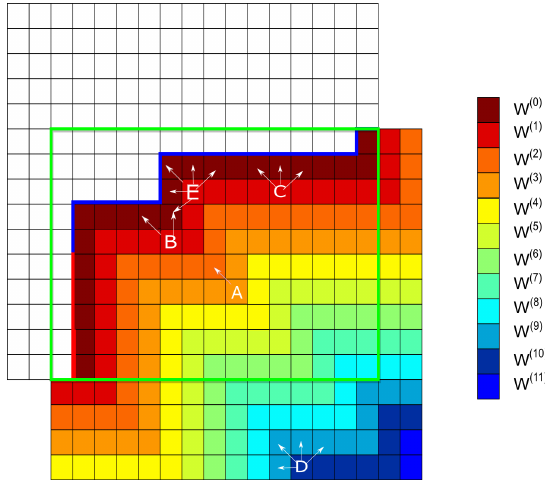
Figure 6. Constructing all wavefronts for target pixels in Ω t